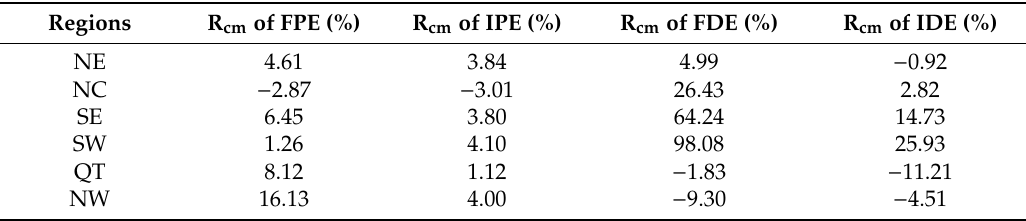
Table 1. Station mean change rate of precipitation and drought extremes in the six regions. Regions